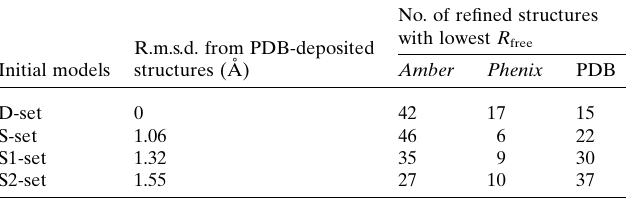
Table 1 The number of first-place finishes, as judged by the lowest R free , in a three- way competition between Amber -refined, Phenix -refined and PDB- deposited structures. The results are from the test set including 74 protein structures (see Section